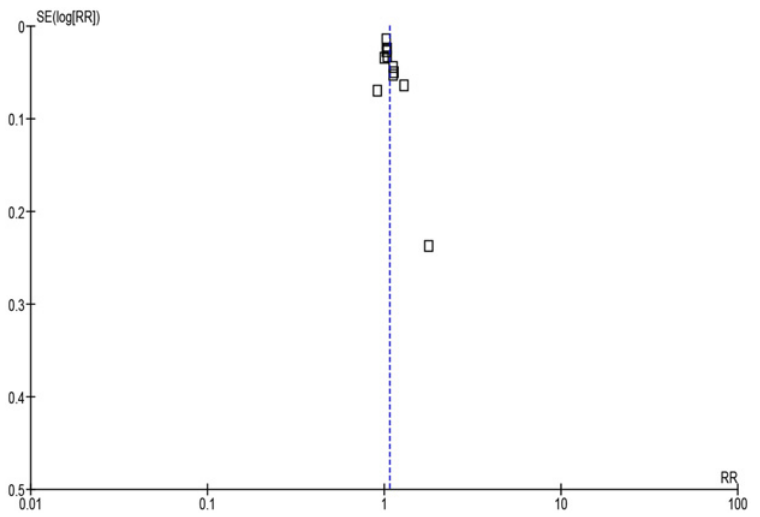
Figure 3. Forest plot depicting the risk ratios (RR) of compliance of patients receiving antibiotic treatment twice-daily versus thrice or four times daily.